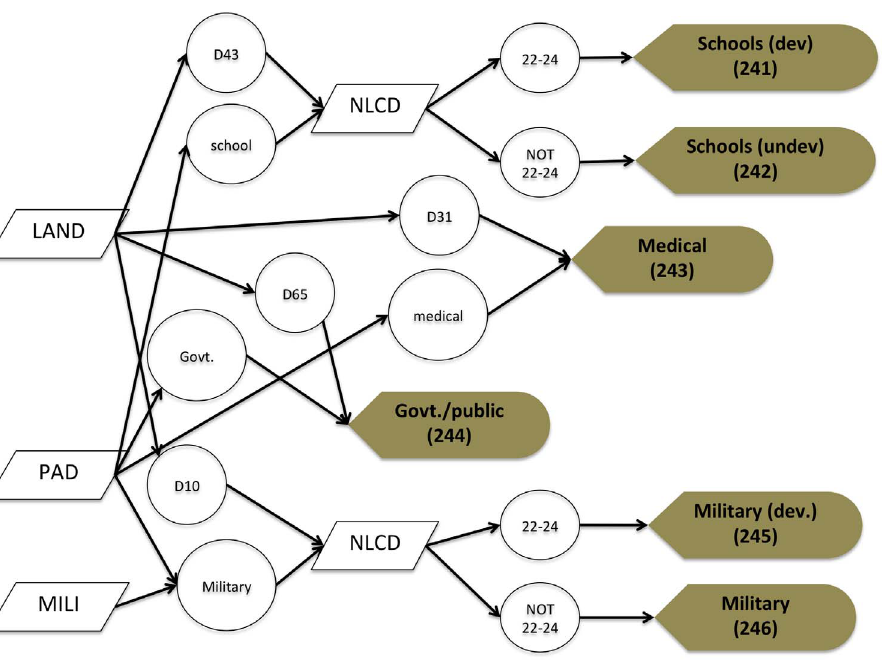
Figure 3. A flow chart depicting the process to map institutional land uses. Educational uses are mapped through Census landmark polygons (LAND) with values of D43 (Educational institution, including academy, school, college, and university) or if designated as a school in the Protected Areas Database US v1.3 (PAD). Educational institutions are further classified as developed (including buildings and playgrounds) using the National Land Cover Dataset 2006 (NLCD) with built-up values 22–24, or undeveloped (that includes grass fields and other vegetation types). Medical uses and government/public uses are mapped similarly, using LAND values = D31 (hospitals) or PAD designation as a hospital or other medical use; or D65 (government complex) or government designation from PAD. Military uses are depicted using LAND with values of D10 or as mapped in PAD or in the military polygons from the National Transportation Atlas Database 2010 (MILI). Developed portions of military lands, which can range from airports to storage facilities to residential uses, are differentiated using NLCD built-up values 22–24 (or if not, then are mapped as